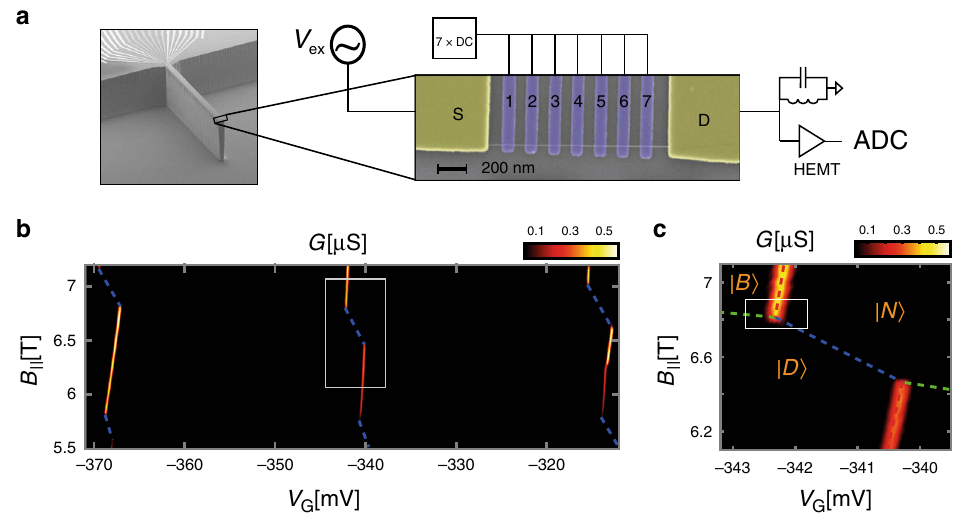
Fig. 2 Experimental setup and transport signature. a Scanning electron microscope image of the device: At the edge of an etched cantilever, a nanotube is positioned on two contacts (S,D) and suspended over a piano of seven gates. The conductance through the device is measured with an AC excitation on S ( V ex at ~1.5 MHz) and a cryogenic LC tank circuit connected to the drain (D) followed by a cold HEMT ampli fi er. b Measured conductance, G , as a function of gate voltage common to all seven gates, V G , and B || , exhibiting a zig-zag of bright and dark charging lines (the latter marked by dashed blue). c Zoom-in on one triple point, with the schematic lines separating the N j i , D j i and B j i states are marked as in Fig.